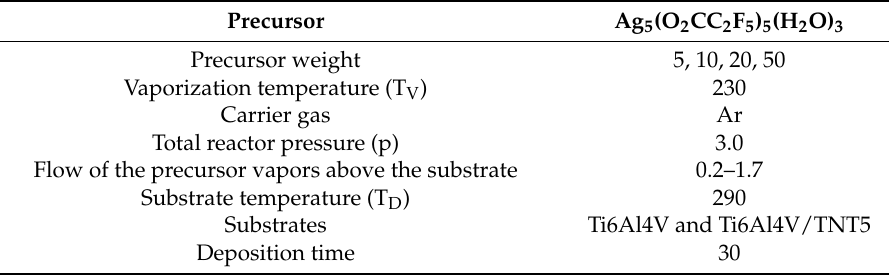
Table 1. The silver nanograins CVD